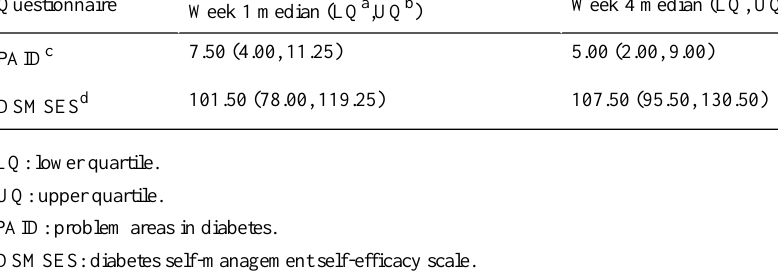
P valueNoncompletersCompletersRegistered people with T2DMVariable